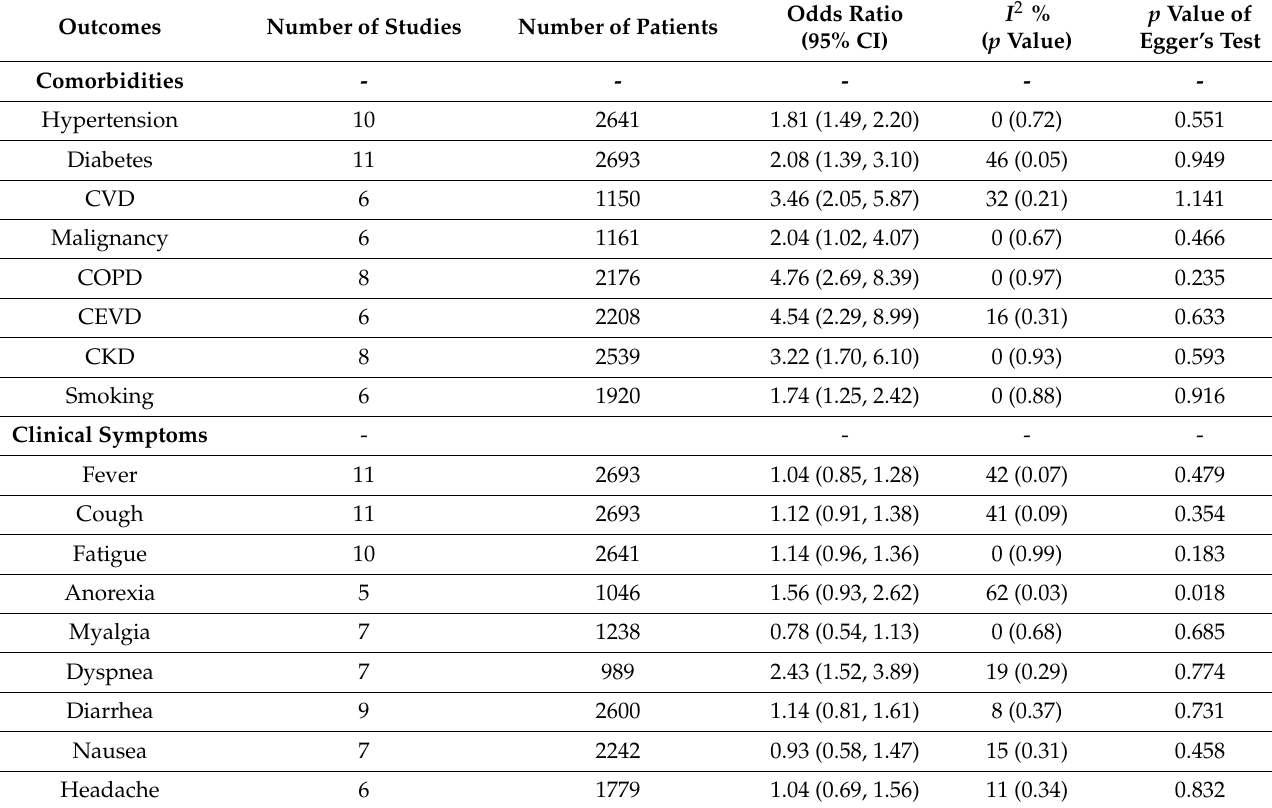
Table 4. Odds ratio representing the severity of comorbidities and symptoms in COVID-19 patients obtained from meta- analysis of published